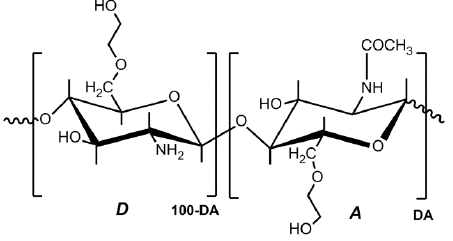
Figure 12. The chemical structure of glycol chitosan.